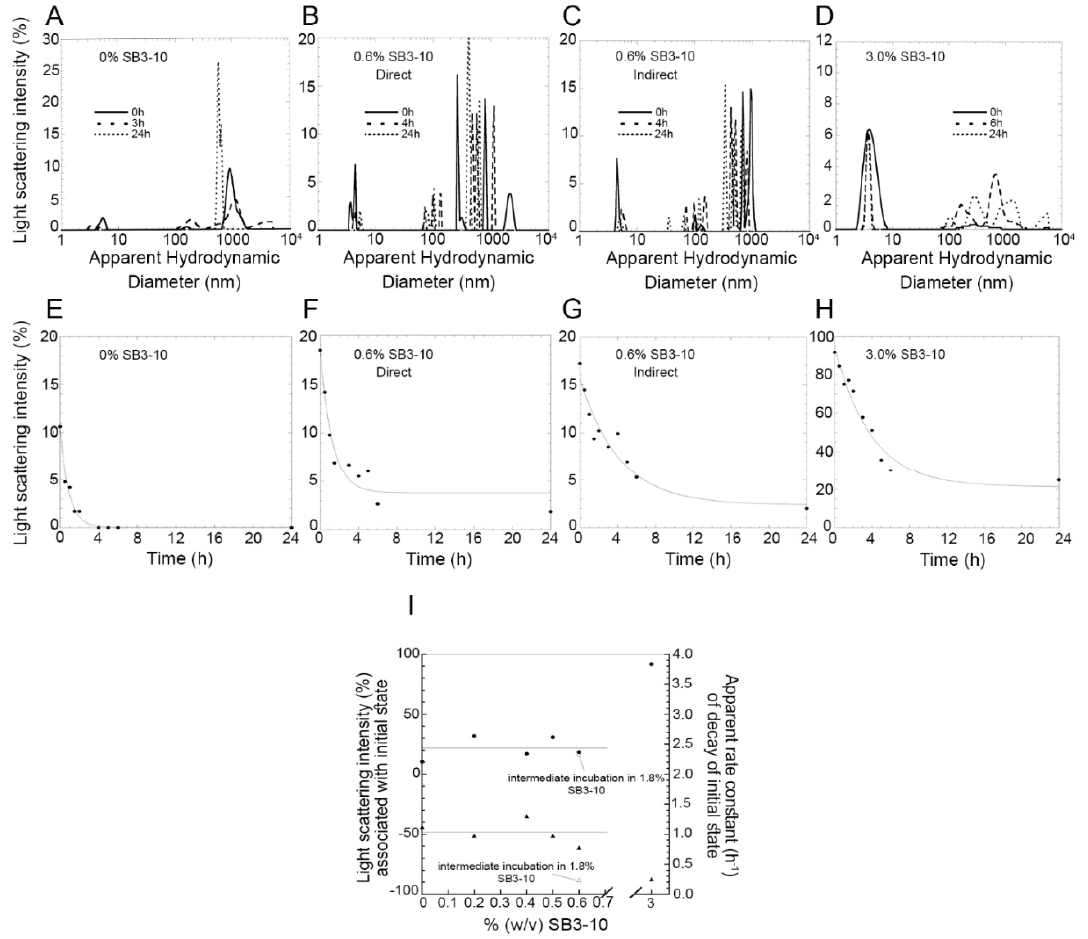
Figure 6. Aggregation kinetics of TDP-43 NTD at different SB3-10 percent concentrations monitored with DLS. ( A – D ) Size distributions of TDP-43 NTD (0.5 mg/mL, 45 µM) in 5 mM sodium phosphate buffer, 50 mM NaCl, 1 mM DTT, pH 7.4, 25 °C, in the presence of 0.0% ( w/v ) SB3-10 ( A ), 0.6% ( w/v ) SB3-10 ( B , C ), 3.0% ( w/v ) SB3-10 ( D ), after 0 h (continuous lines), 3–6 h (dashed lines) and 24 h (dotted lines). ( E – H ) Light scattering intensity associated with the initial state (low-molecular weight monomer/dimer/oligomer) of TDP-43 NTD versus time. Conditions as in the corresponding top panels. In panels ( C ), ( G ) TDP-43 NTD was pre-incubated in 1.8% ( w/v ) SB3-10 for 1 h and then diluted to 0.6% ( w/v ) SB3-10 at the same final conditions as in panels ( B , F ). ( I ) Light scattering intensity associated with initial state (circles), and apparent rate constant of decay of initial state (triangles), versus SB3-10 percentage ( w/v ). The empty symbols refer to the sample pre-incubated in 1.8% ( w/v ) SB3-10 for 1 h and then diluted to 0.6% ( w/v ) SB3-10. Horizontal lines indicate mean values. All data were acquired using a fixed attenuator and measurement position on the instrument.